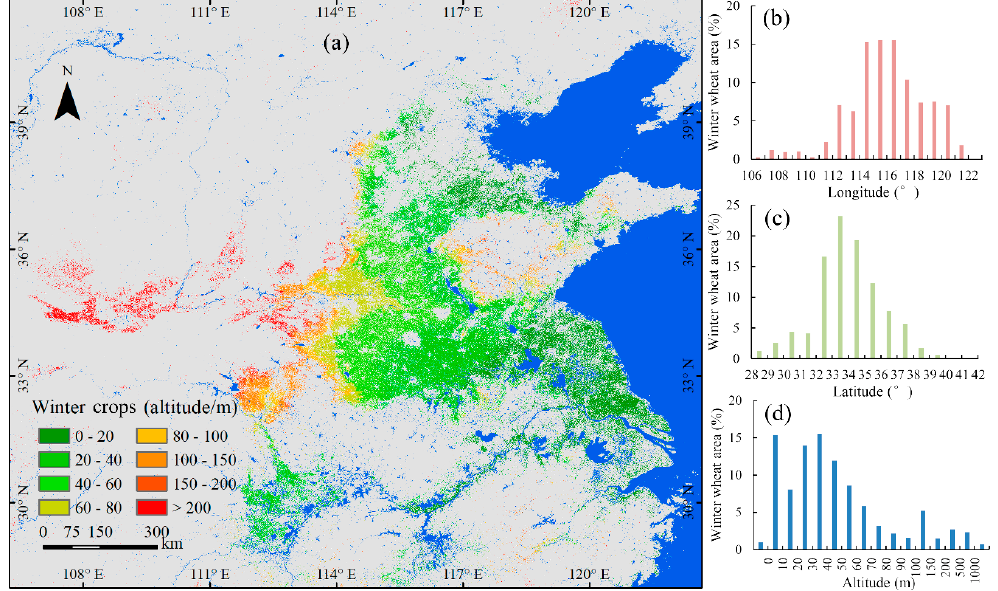
Figure 7. Map of winter crops in 2018, including spatial and altitude distribution.